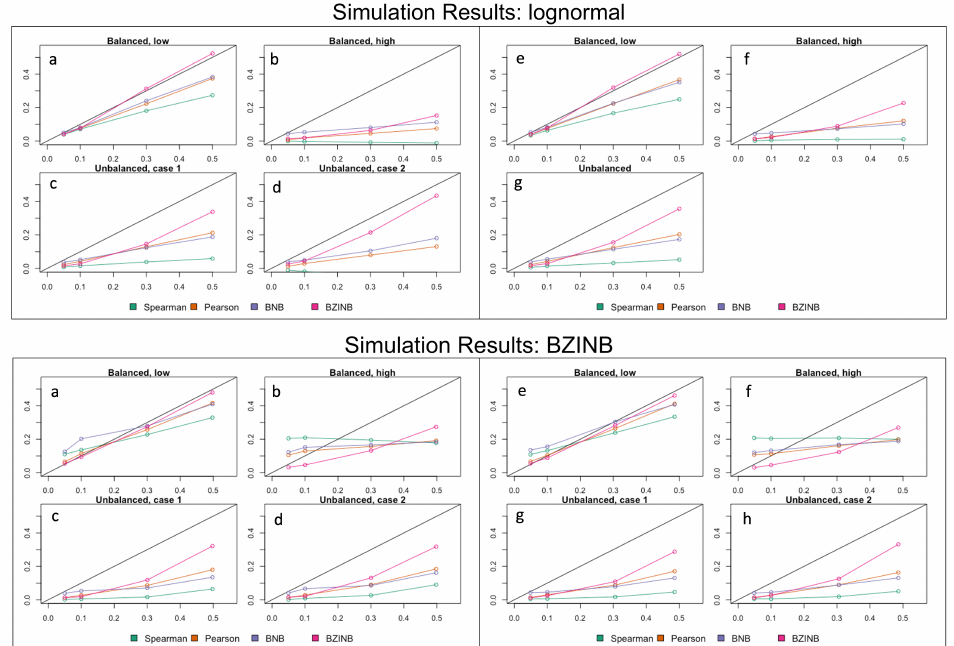
Figure 2. ( Upper panel ) Mean approximated correlation for simulation of lognormal vectors repre- senting pairs of metabolites and species corresponding to the ( a ) balanced, low, ( b ) balanced, high, ( c ) unbalanced, case 1, ( d ) unbalanced, case 2 expected numbers of zeros (parameters in Table 1); mean approximated correlation for simulation of lognormal vectors representing pairs of species corresponding to the ( e ) balanced, low, ( f ) balanced, high, ( g ) unbalanced expected numbers of zeros (parameters in Table 2). Each figure compares Spearman, Pearson, BNB-based, and BZINB-based correlations for five values of underlying correlation from the distributions from which the simulated vectors are drawn. In each plot, the x -axis represents the underlying correlation of the bivariate lognormal distribution from which the simulated vector pairs are drawn; the y -axis represents the mean estimated correlation for 1000 simulated replicates. ( Lower panel ) Mean approximated correla- tion for simulation of BZINB vectors representing pairs of metabolites and species corresponding to the ( a ) balanced, low, ( b ) balanced, high, ( c ) unbalanced, case 1, ( d ) unbalanced, case 2 expected numbers of zeros (parameters in Table 2 and Appendix A Table A1); mean approximated correlation for simulation of BZINB vectors representing pairs of species corresponding to the ( e ) balanced, low, ( f ) balanced, high, ( g ) unbalanced, case 1, ( h ) unbalanced, case 2 expected numbers of zeros